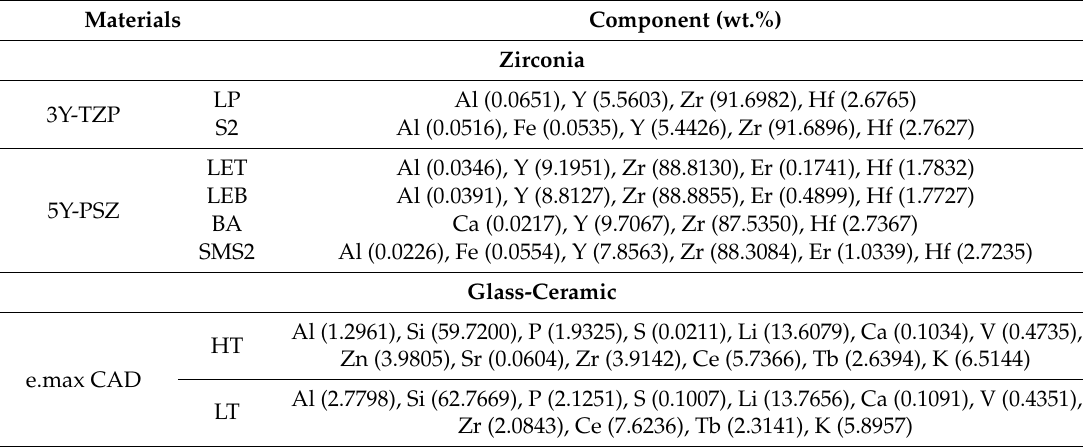
Table 2. The mass percent composition of each specimen determined by X-ray fluorescence (XRF). Materials Component (wt.%)